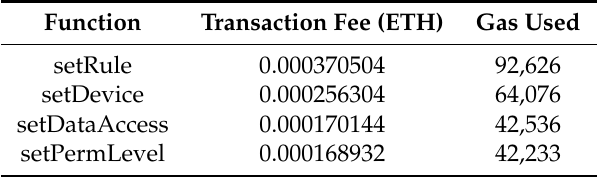
Table 5. Environment contract cost.